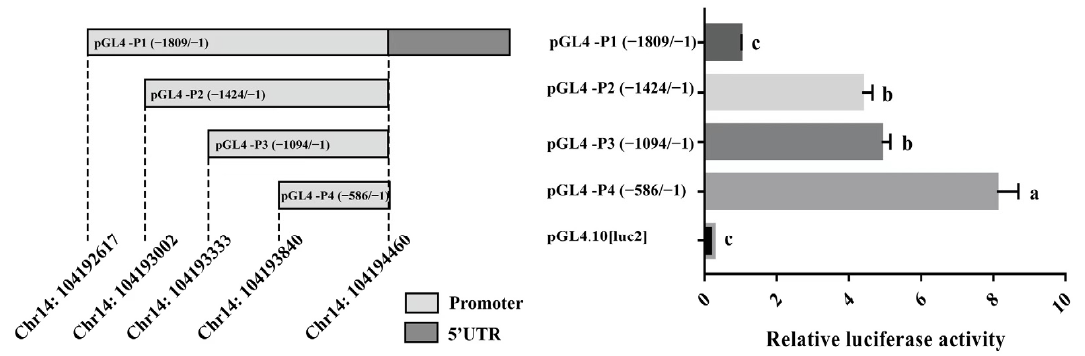
Figure 4. Porcine HHEX promoter transcriptional activity analyses. The left image indicates the length and structure of the fragments, and the right image indicates the corresponding relative luciferase activity. The luciferase activity was normalized, and the relative values were expressed as the fold of induction relative to the pGL4.10[luc2] vector activity. The relative luciferase activity values represent the mean ± SEM of three independent experiments. A one-way ANOVA test was used to assess the differences in luciferase activity. Different letters (a, b, and c) indicate that the difference is significant ( p <